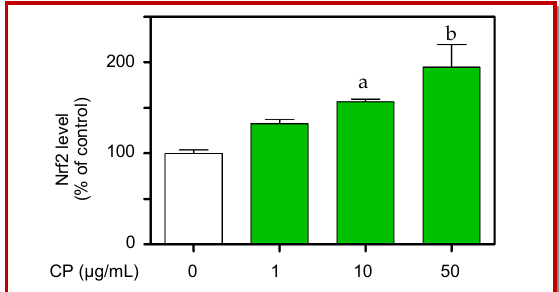
Figure 2: Effects of Cicadidae Periostracum (CP) on the nucle- ar factor E2-related factor 2 (Nrf2) level. Nrf2 DNA-binding activity was measured using an enzyme-linked immuno- sorbent assay in differentiated PC12 cells. a p<0.05 and b p< 0.01 compared with the control